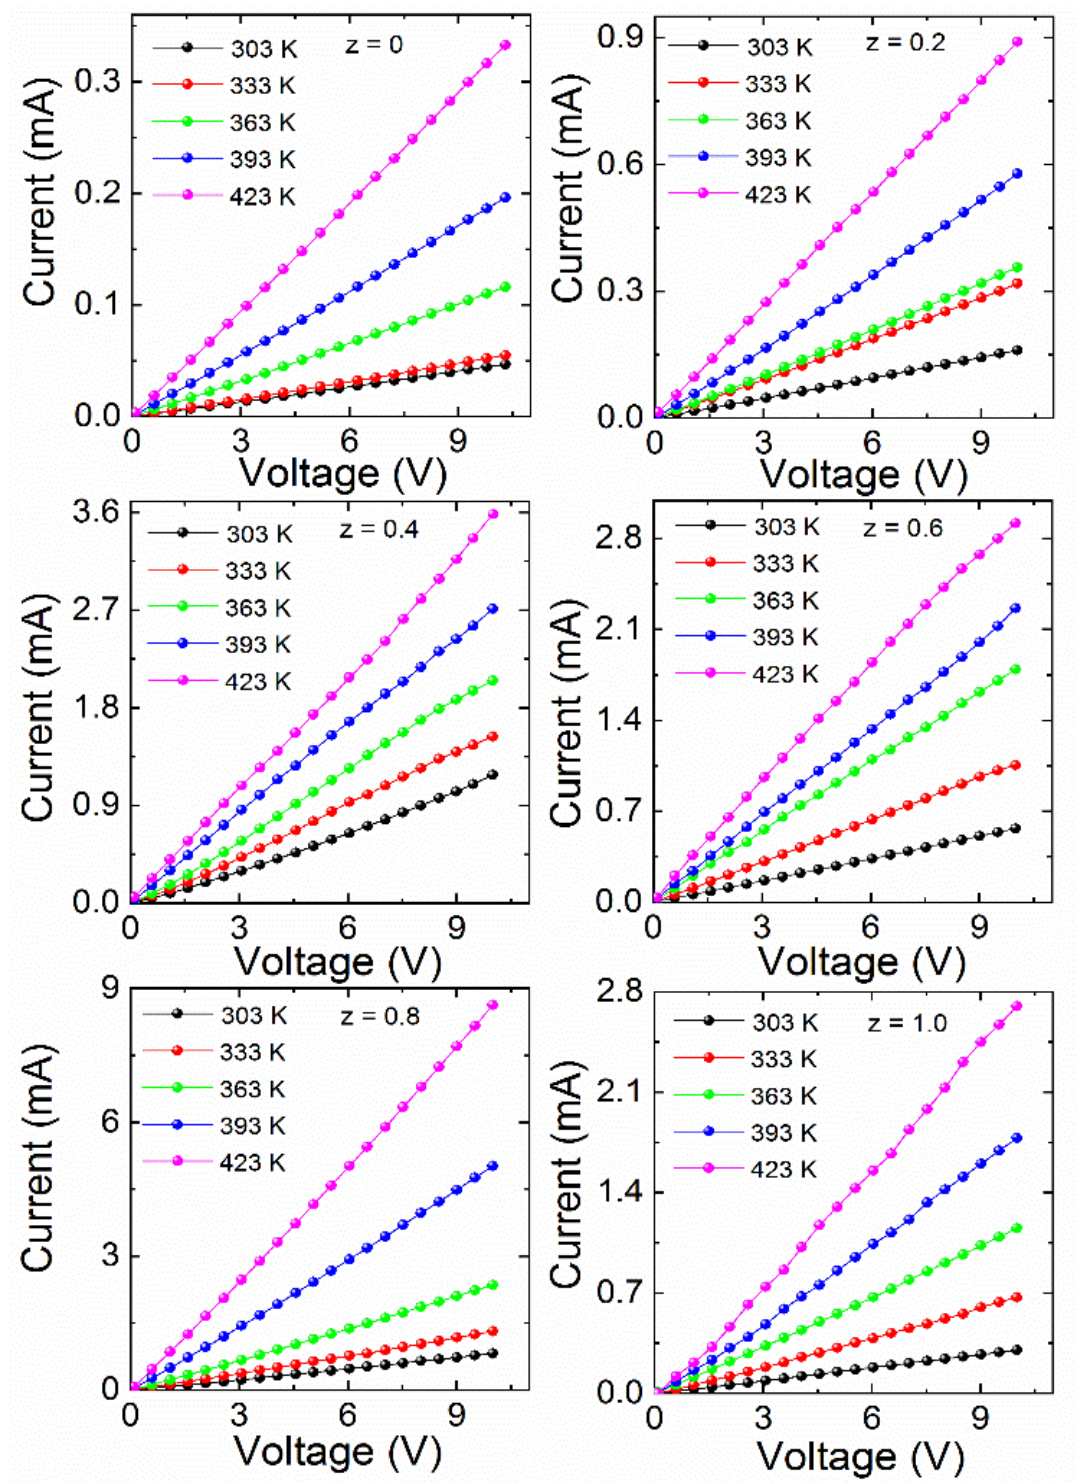
Figure 5. I – V curves at various temperatures for La 2 Co 1−z Fe z MnO 6 (z = 0, 0.2 – 1.0). According to the adiabatic nearest-neighbor hopping over small polarons (Holstein polaron) model (ANHSP), the decline in resistivity with the enhancement in temperature is due to the thermally triggered charges corresponding to the conduction mechanism of hopping [21 – 23], and the activation energy of the samples was calculated based on the formula expressed in Equation (6), with the help of the Arrhenius plot of Ln ρ versus 1/ k β T . 𝜌 𝐸 = 𝑘 𝑇𝐿𝑛 ( ˳) (6) 𝑎 𝜌 where β is the Boltzmann constant, E a is the activation energy, ρ represents the resistivity, and T is the absolute temperature. The activation energy of the samples increases with the mole percentage